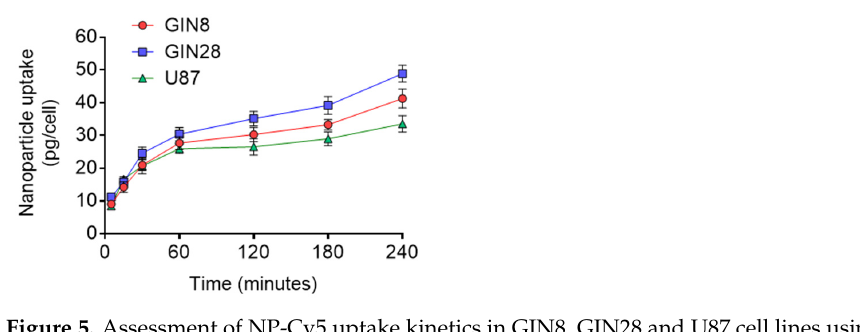
Figure 5. Assessment of NP-Cy5 uptake kinetics in GIN8, GIN28 and U87 cell lines using the fluorometric method. Cy5-NP P2 was applied at 50 µg/mL in 10% ( v / v ) containing DMEM. Data presented as the mean ± S.D ( n = 3).